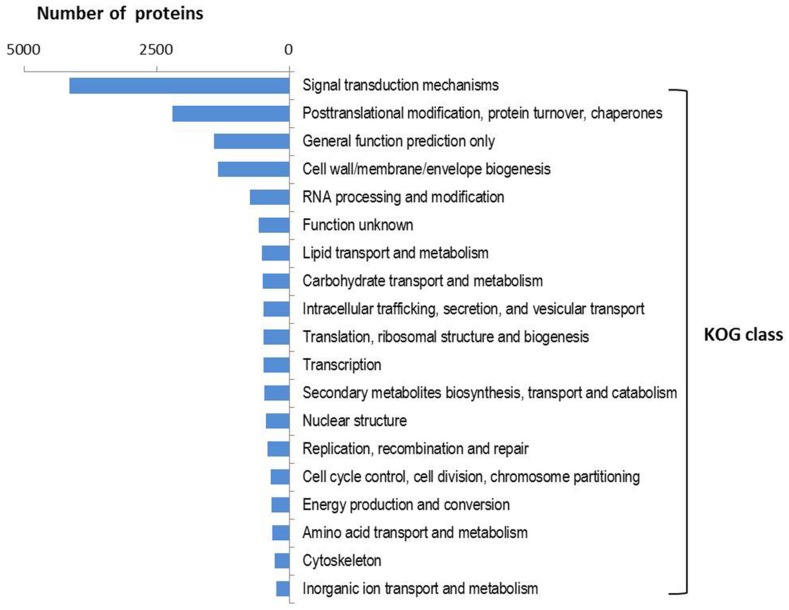
KOG function class distribution in the predicted proteome of G. rosea. A total of 2961 KOG groups were assigned to 11505 G. rosea proteins using the webMGA tool with an e-value cut-off of 1E-5. The distribution of 25 KOG function classes to which these KOG groups belong is summarized as the percentages.